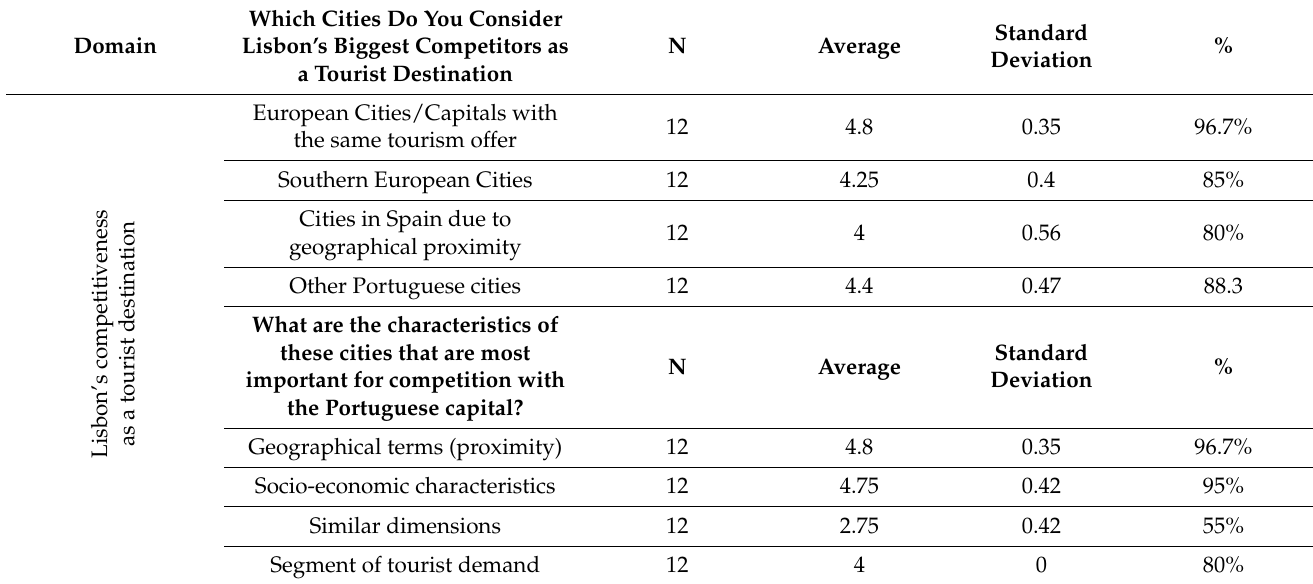
Table 14. Results of the second round of interviews—Domain, Key elements to consider in tourism competitiveness analysis. Source: Elaborated by the author.